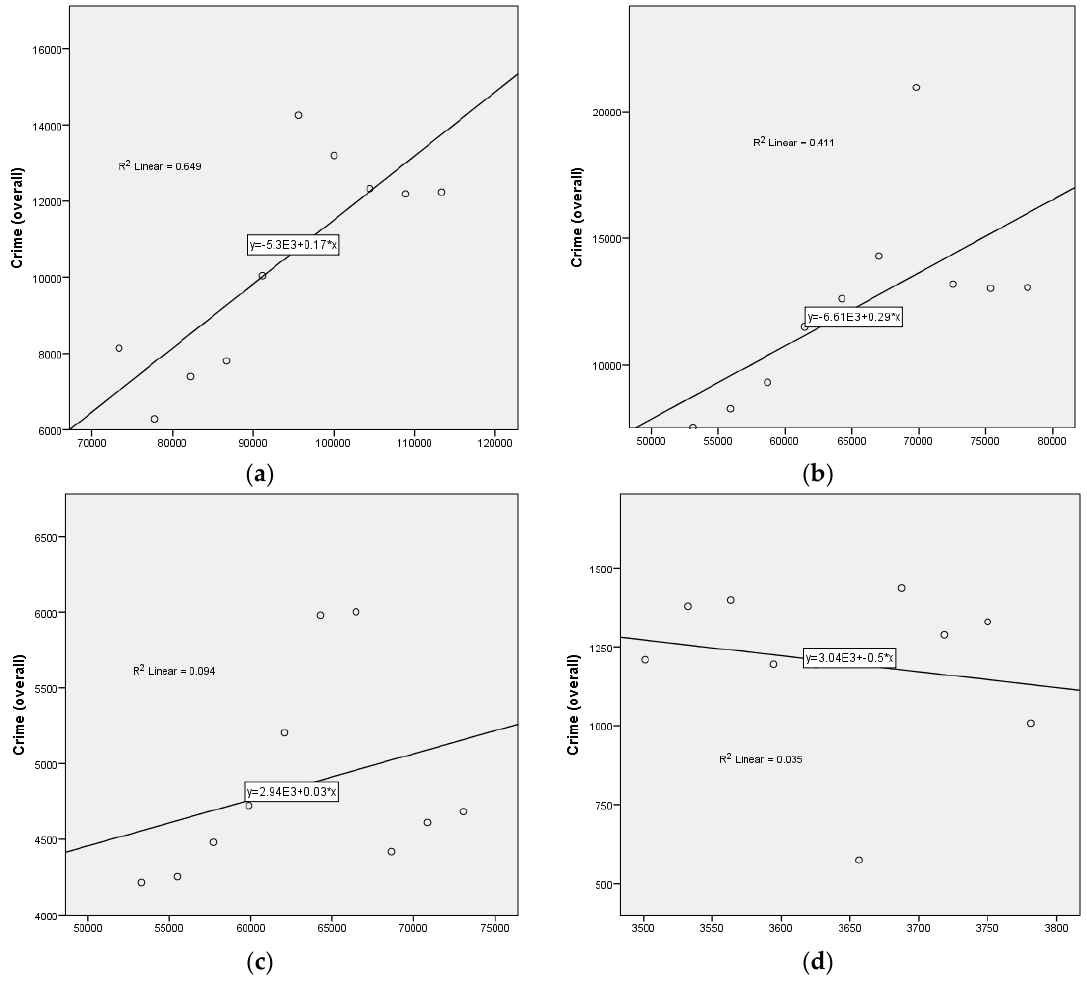
Figure 7. Correlation coefficient between overall crime and urban expansion in Riyadh, Makkah, the East Area, and Tabouk. ( a ) Urban changes in Riyadh (ha); ( b ) Urban changes in Makkah (ha); ( c ) Urban changes in East Area (ha); ( d ) Urban changes in Tabouk (ha).